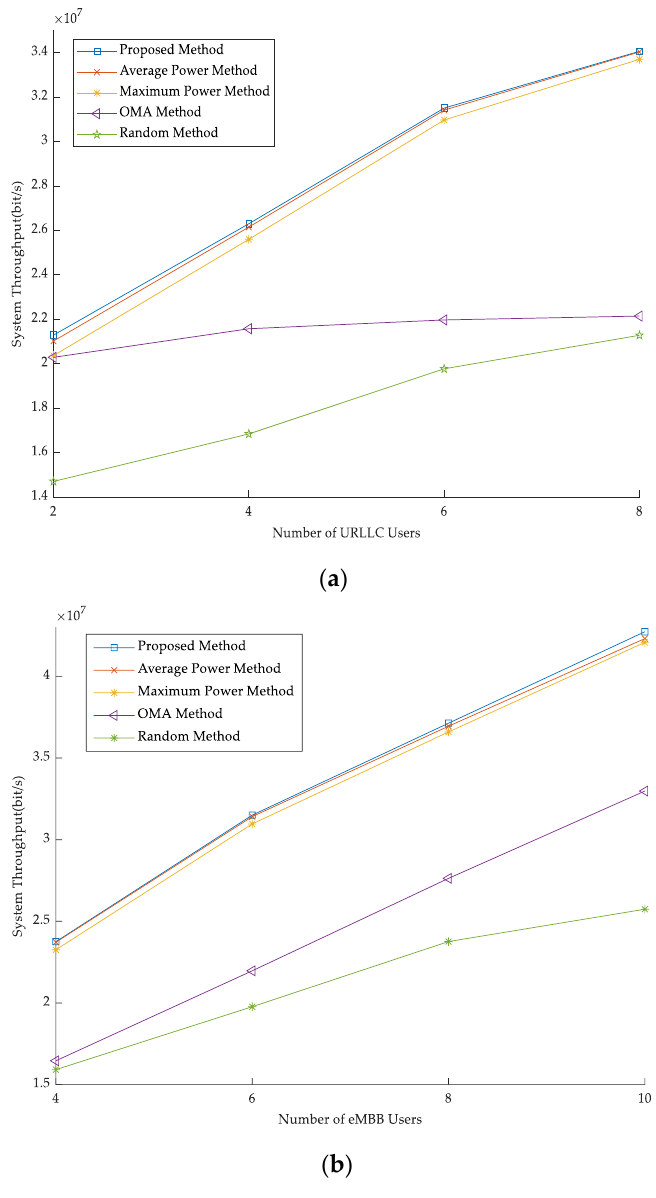
Figure 3. The number of users versus throughput. ( a ) The number of URLLC users versus throughput. ( b ) The number of eMBB users versus throughput.